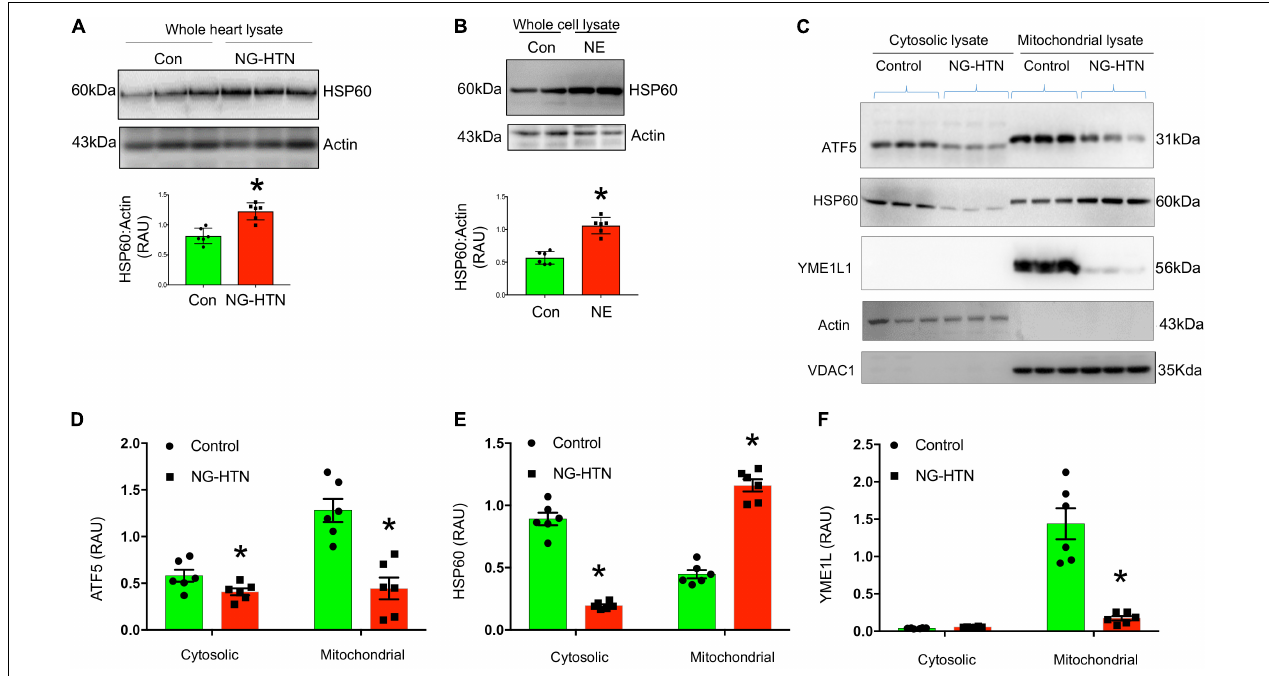
FIGURE 8 | Neurogenic hypertension (NG-HTN) downregulates mitochondrial UPR (UPR mt ). (A) Representative Western blots and quantification of cardiac HSP60 expression normalized to Actin in control and NG-HTN whole hearts lysate. (B) Representative Western blots and quantification of HSP60 expression normalized to Actin in NE-treated H9c2 whole cell lysate. (C) Representative Western blots and (D–F) quantifications of cytosol vs. mitochondrial ATF5, HSP60, and YME1L1 expression level normalized to loadings controls in NG-HTN and control hearts. Values are mean ± SEM, dot represents n = 6 rats, * P < 0.05 vs. Control, (A,B)